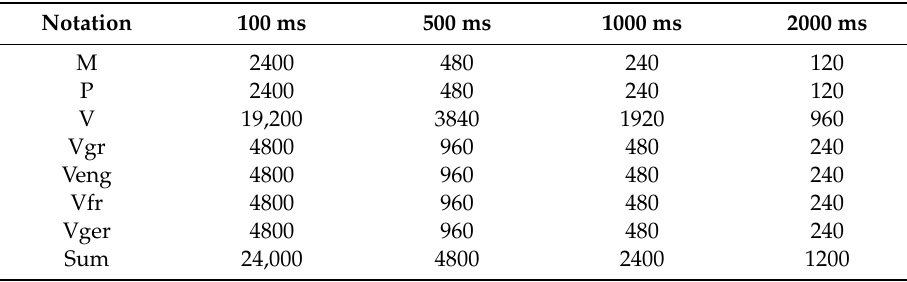
Table 1. Distribution of the input samples.